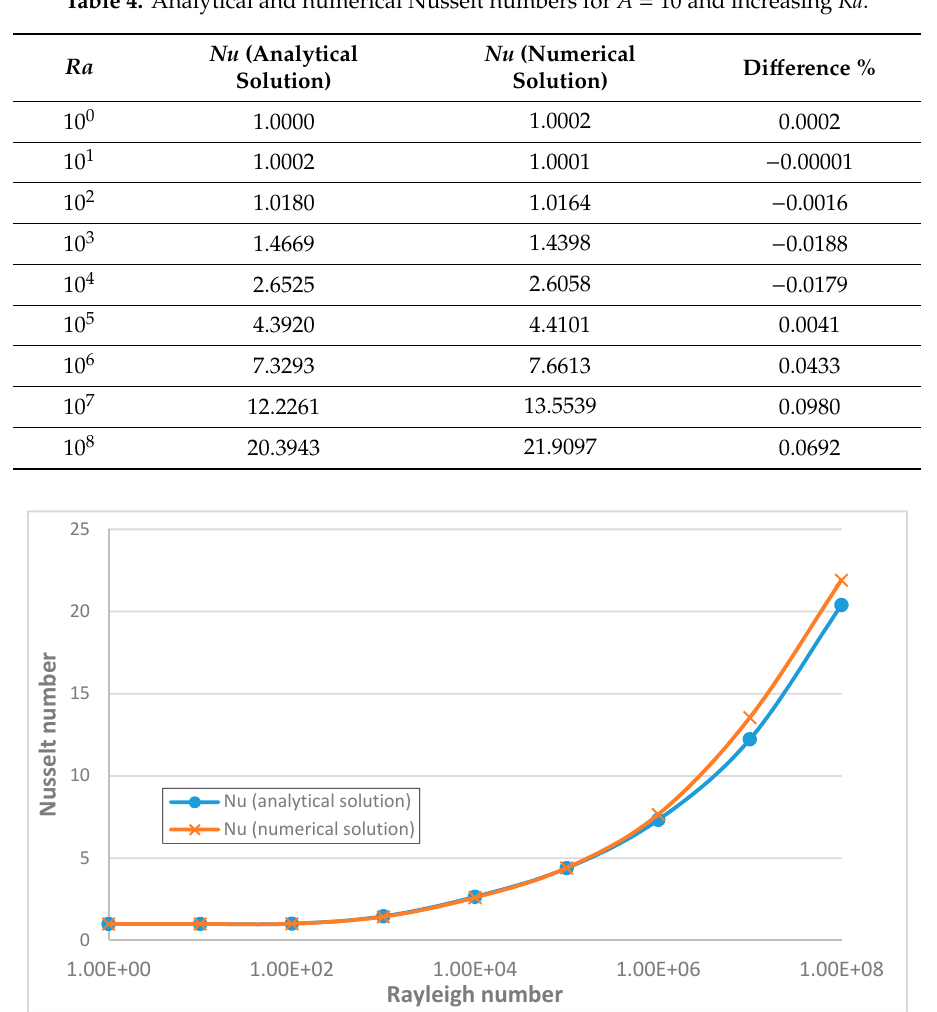
Figure 9. Comparison between the analytical and numerical Nu at increasing values of the Ra having (cid:1827) = 10 .